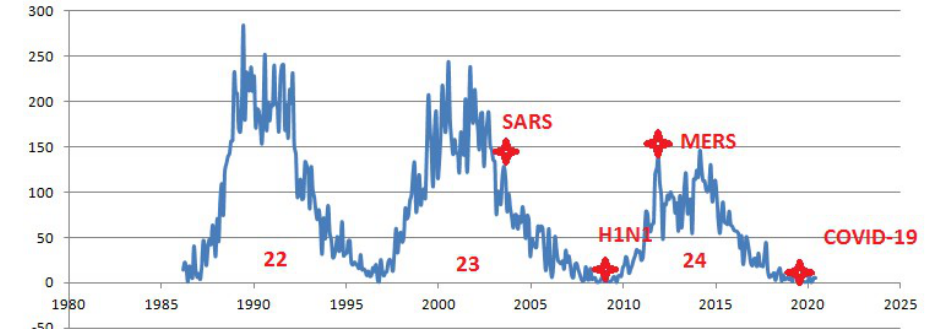
Figure 9 – Outbreaks of SARS, H1N1, MERS, and Covid-19 and their relation with the sunspot numbers and the 11-year